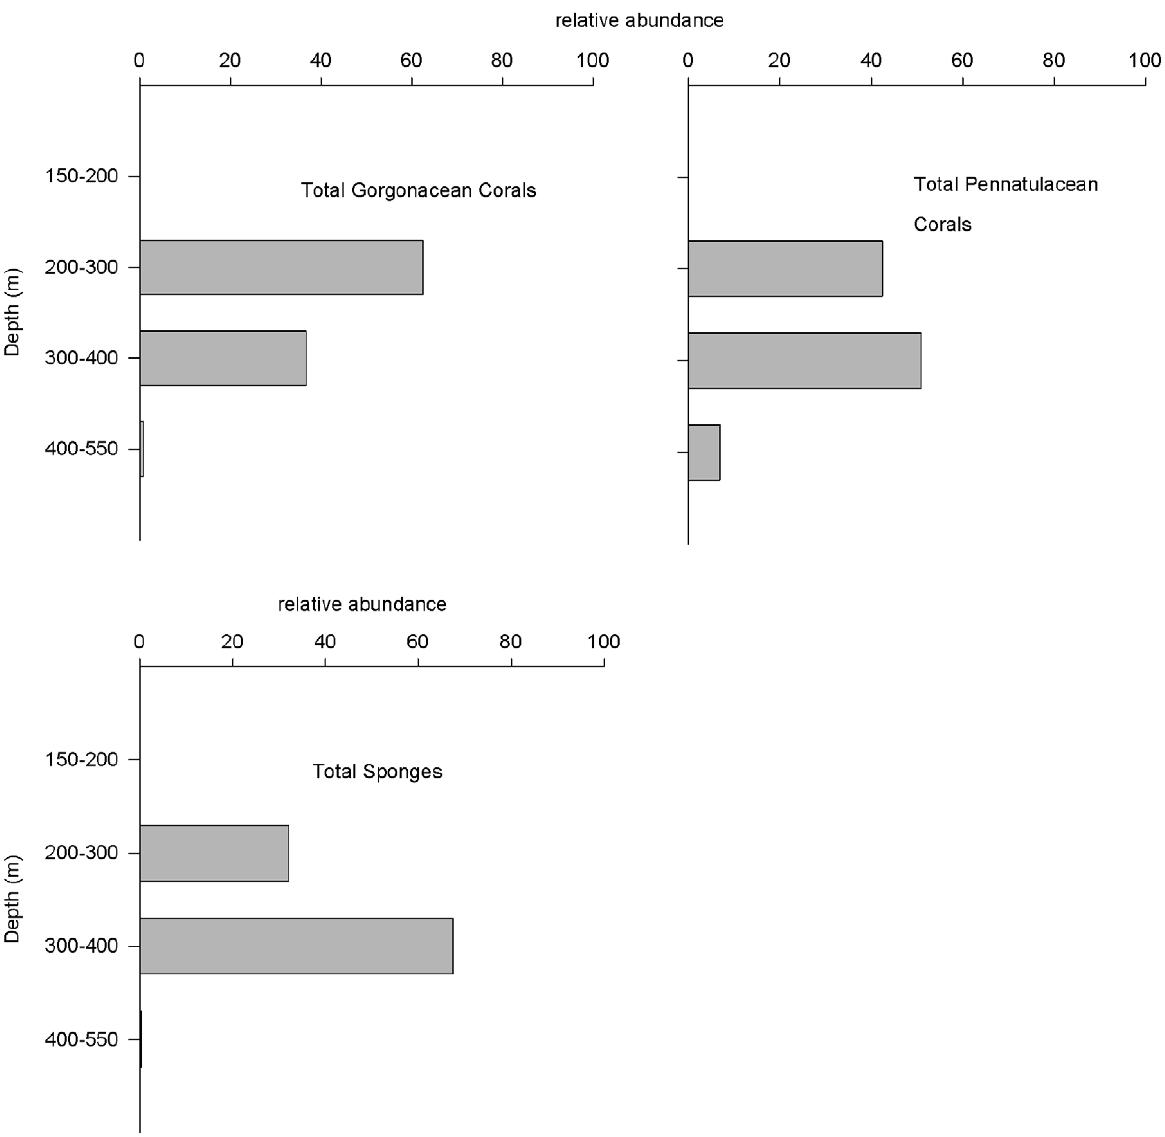
Figure 2. Relative abundance by depth of corals (total gorgonians n=1301, total pennatulaceans n=552) and total sponges (n=1039) in Pribilof and Zhemchug Canyons, Bering Sea. Sample sizes ( # images analyzed) for each depth strata were: 150–200: n=77, 200– 300: n=483, 300–400: n=396, 400–550: n=1872.